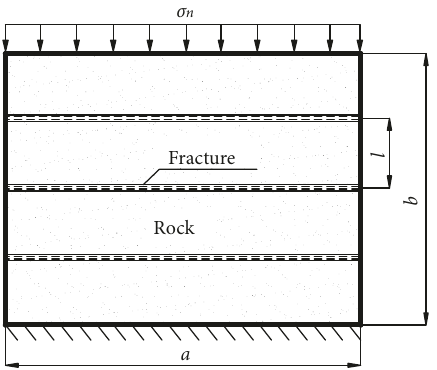
Figure 3: Simple rock unit with uniaxial